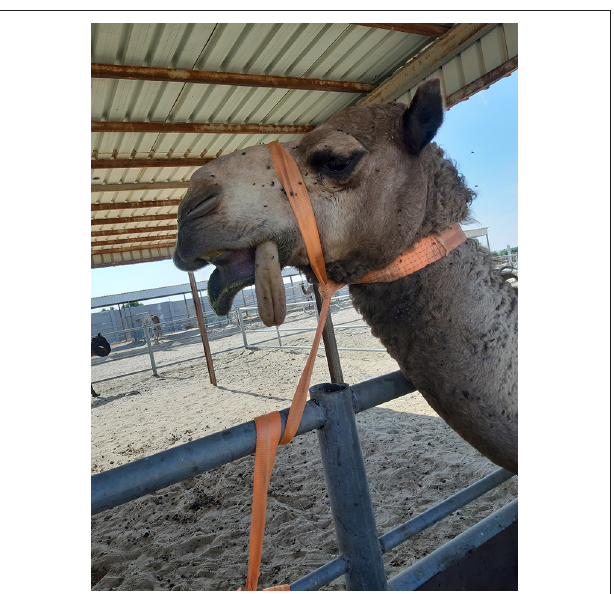
FIGURE 2 | A camel showing moderate degree of sedation (score = 2) post-epidural injection of romifidine (RO) (50 µ g/kg).